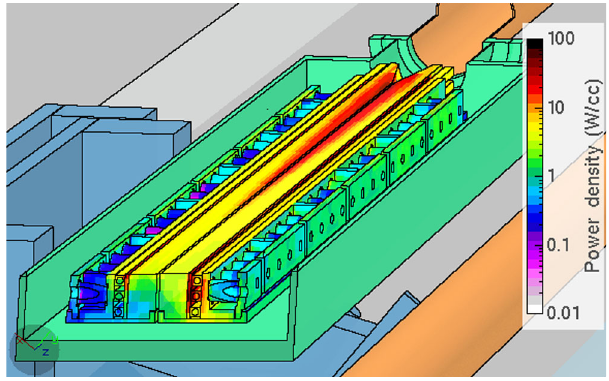
FIG. 6. Absorbed power per unit length in the two most exposed warm dipoles for 0.2 h